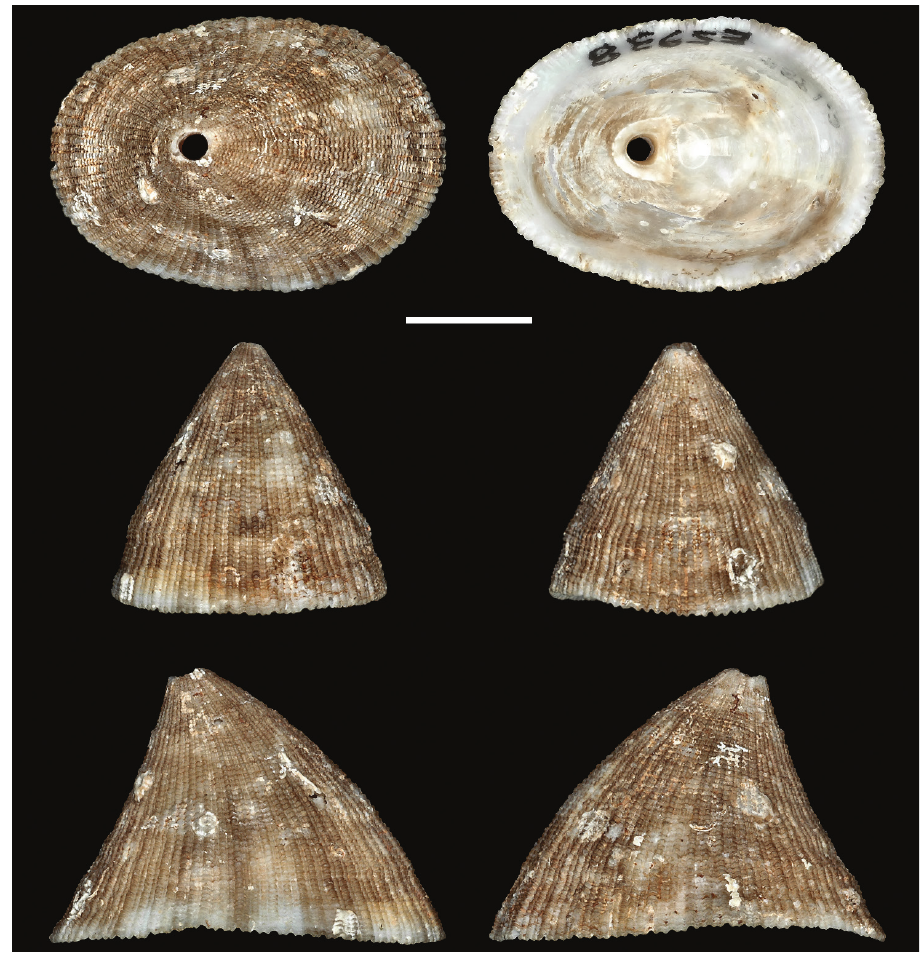
Figure 4. Diodora procurva Herbert, 1989. Holotype T124/NMSA-MOL 0E5938. Scale bar: 10